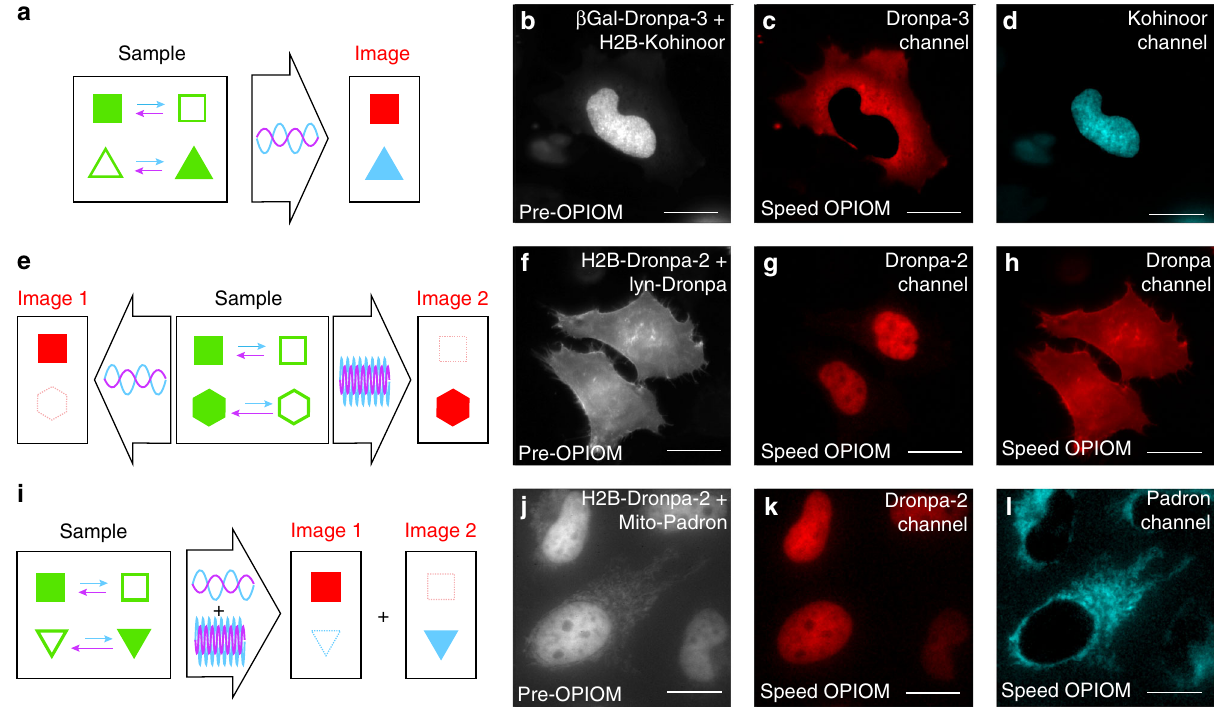
Fig. 4 Speed OPIOM selectively discriminates RSFP signals in the presence of interfering RSFPs. Tuning the illumination parameters enables the selective imaging of RSFPs exhibiting similar resonance conditions but opposite photochromism ( a ) or distinct resonance conditions using light modulation, either sequentially at one frequency ( e ) or simultaneously at multiple frequencies ( i ). Pre-OPIOM and speed OPIOM images tuned to the resonance of Dronpa-3 and Kohinoor ( b – d ), Dronpa-2 ( f , g ) and Dronpa ( h ), or tuned to optimize orthogonality between Dronpa-2 and Padron ( j – l ). Systems: Fixed HeLa cells expressing β Gal-Dronpa-3 and H2B-Kohinoor ( b – d ), H2B-Dronpa-2 and Lyn11-Dronpa ( f – h ), or H2B-Dronpa-2 and Mito-Padron ( j – l ). Localizations: β Gal (cytoplasm), H2B (nucleus), Lyn11 (cell membrane). The images were recorded at 37 °C. Scale bars : 20 µ m. See Supplementary Tables 1 and 2 for